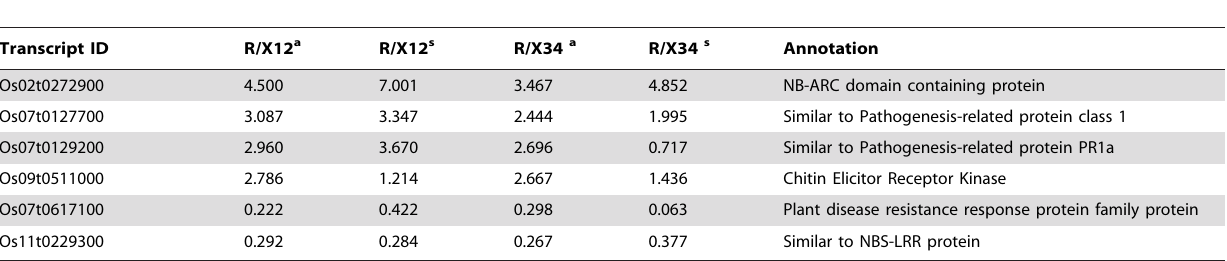
Table 1. Total and allelic expression of six transcripts at tillering and heading